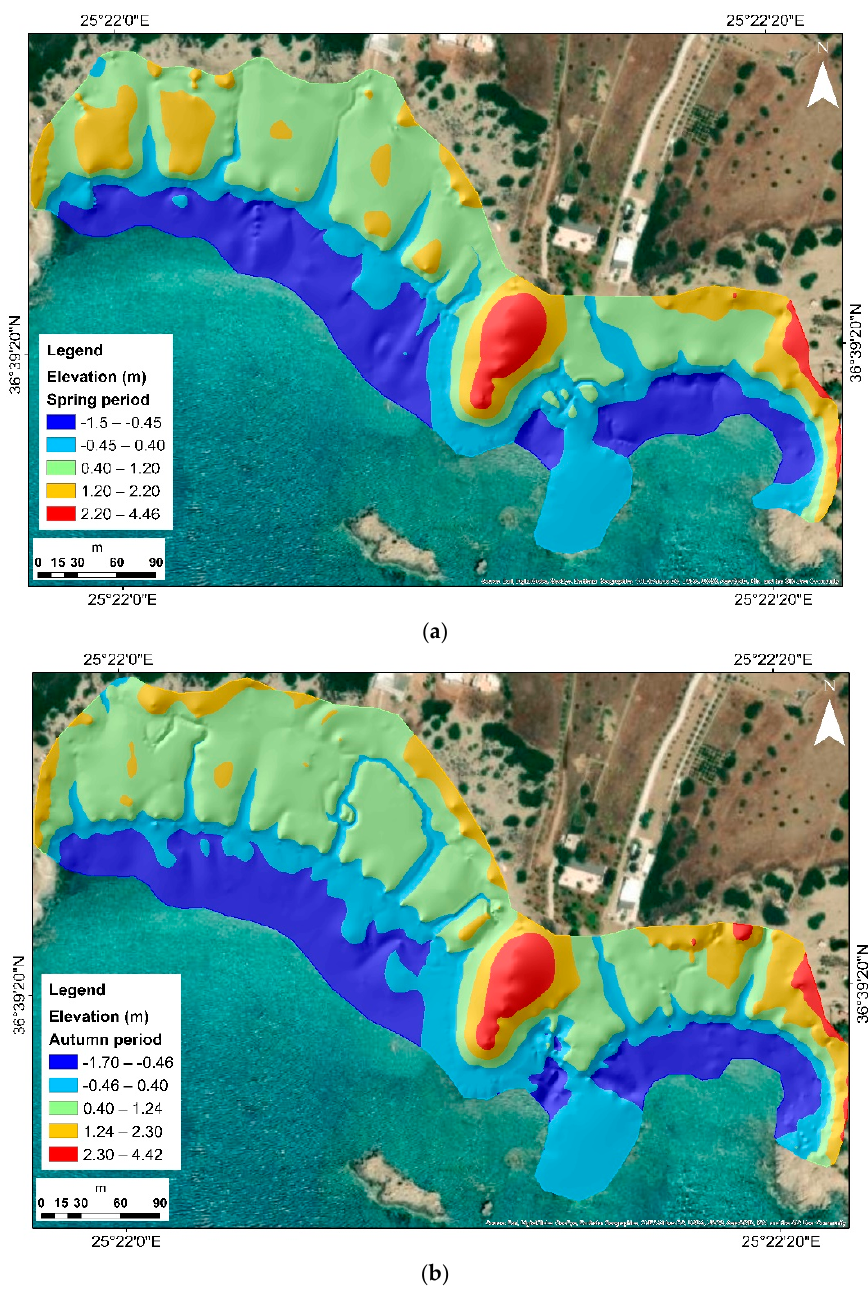
Figure 11. DEM of Magganari beach. ( a ) Shows the values of elevation from seaward to landward for the autumn period. ( b ) Shows the values of elevation from seaward to landward for the spring period.